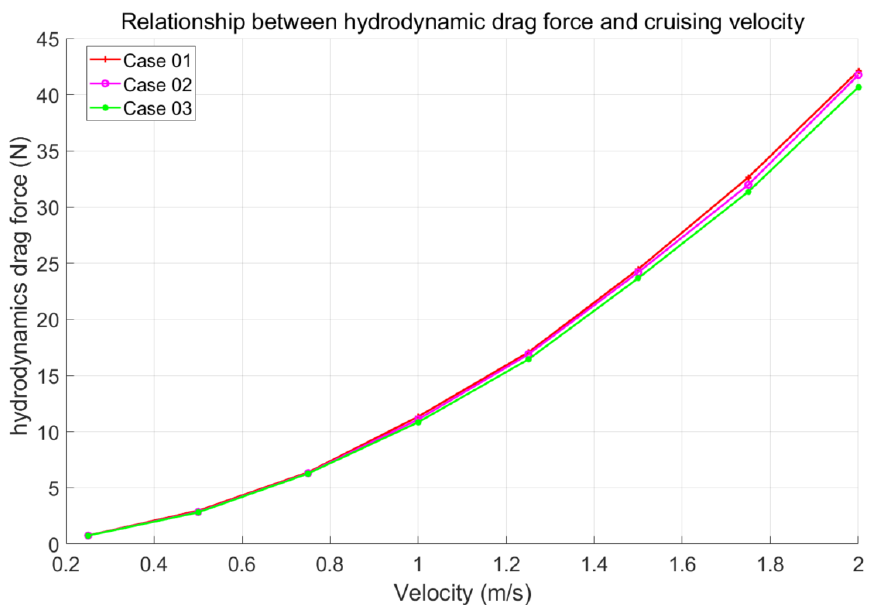
Figure 12. Variation of hydrodynamic drag with velocity.